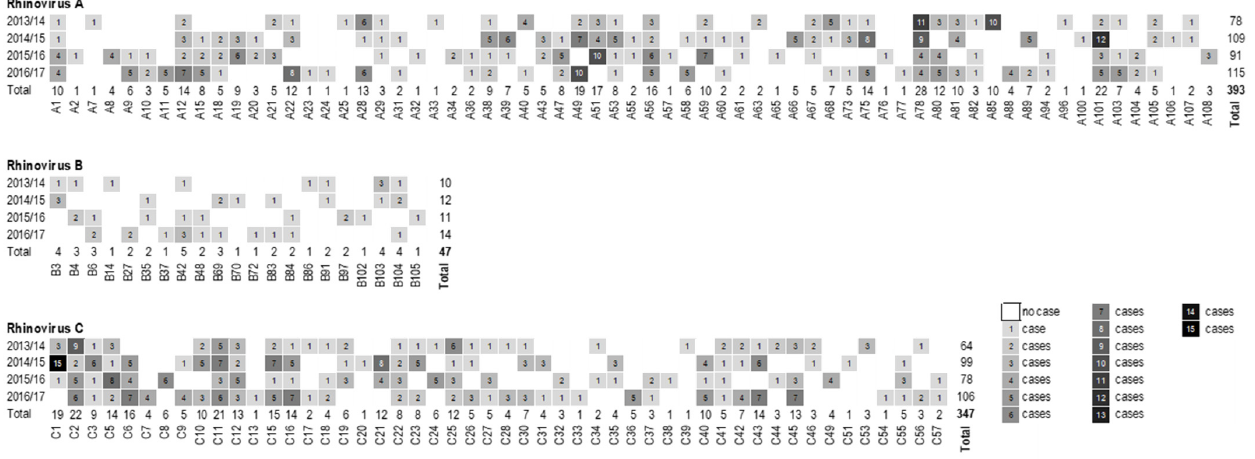
Figure 2. Heat map of the total numbers of RV genotypes (n = 787) detected during the study period stratified by season.